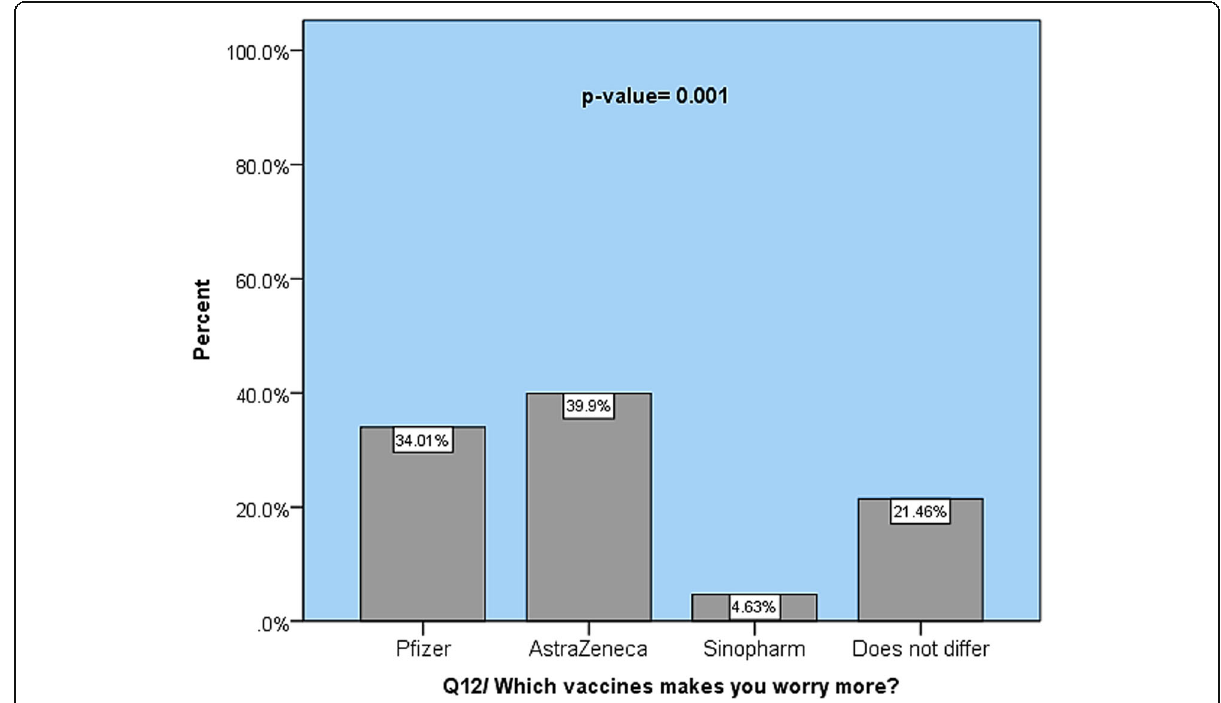
Fig. 2 Public response to types of COVID-19 vaccines concerning fear